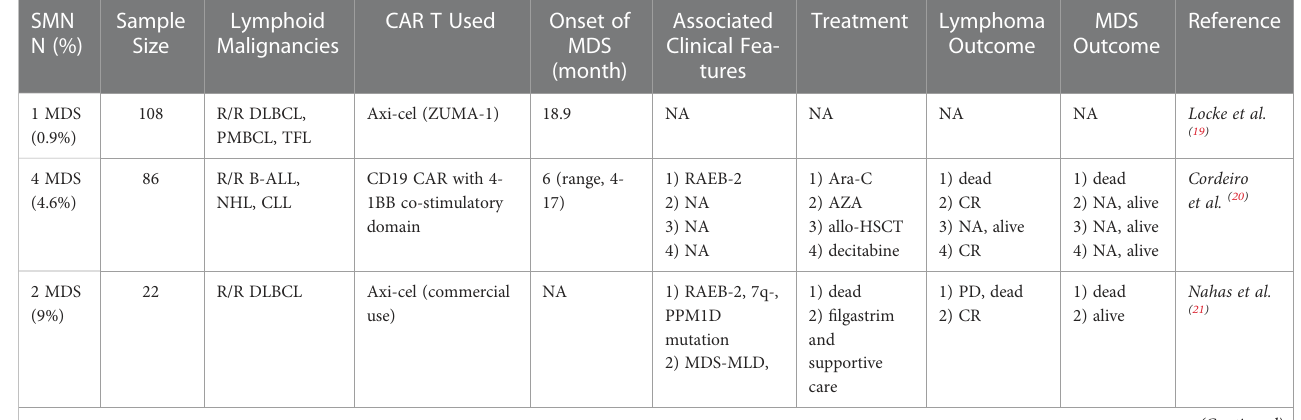
TABLE 3 SMN in a sampling of CD19 CAR T studies. SMN N